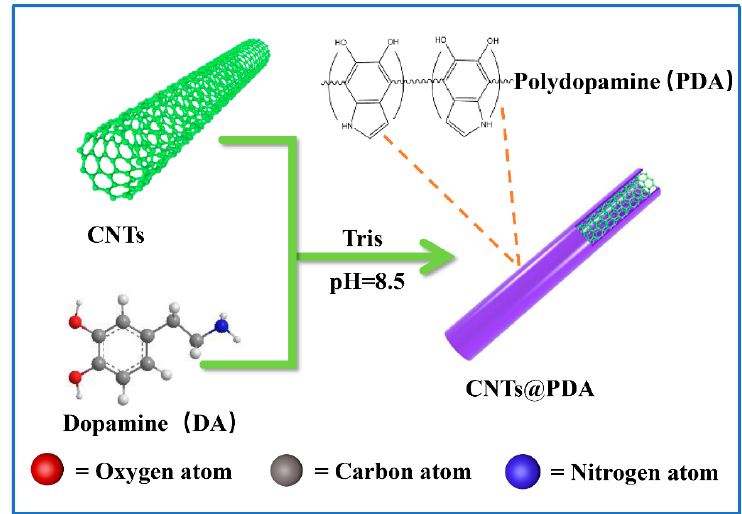
Figure 1. The schematic of preparation process of CNTs@PDA.